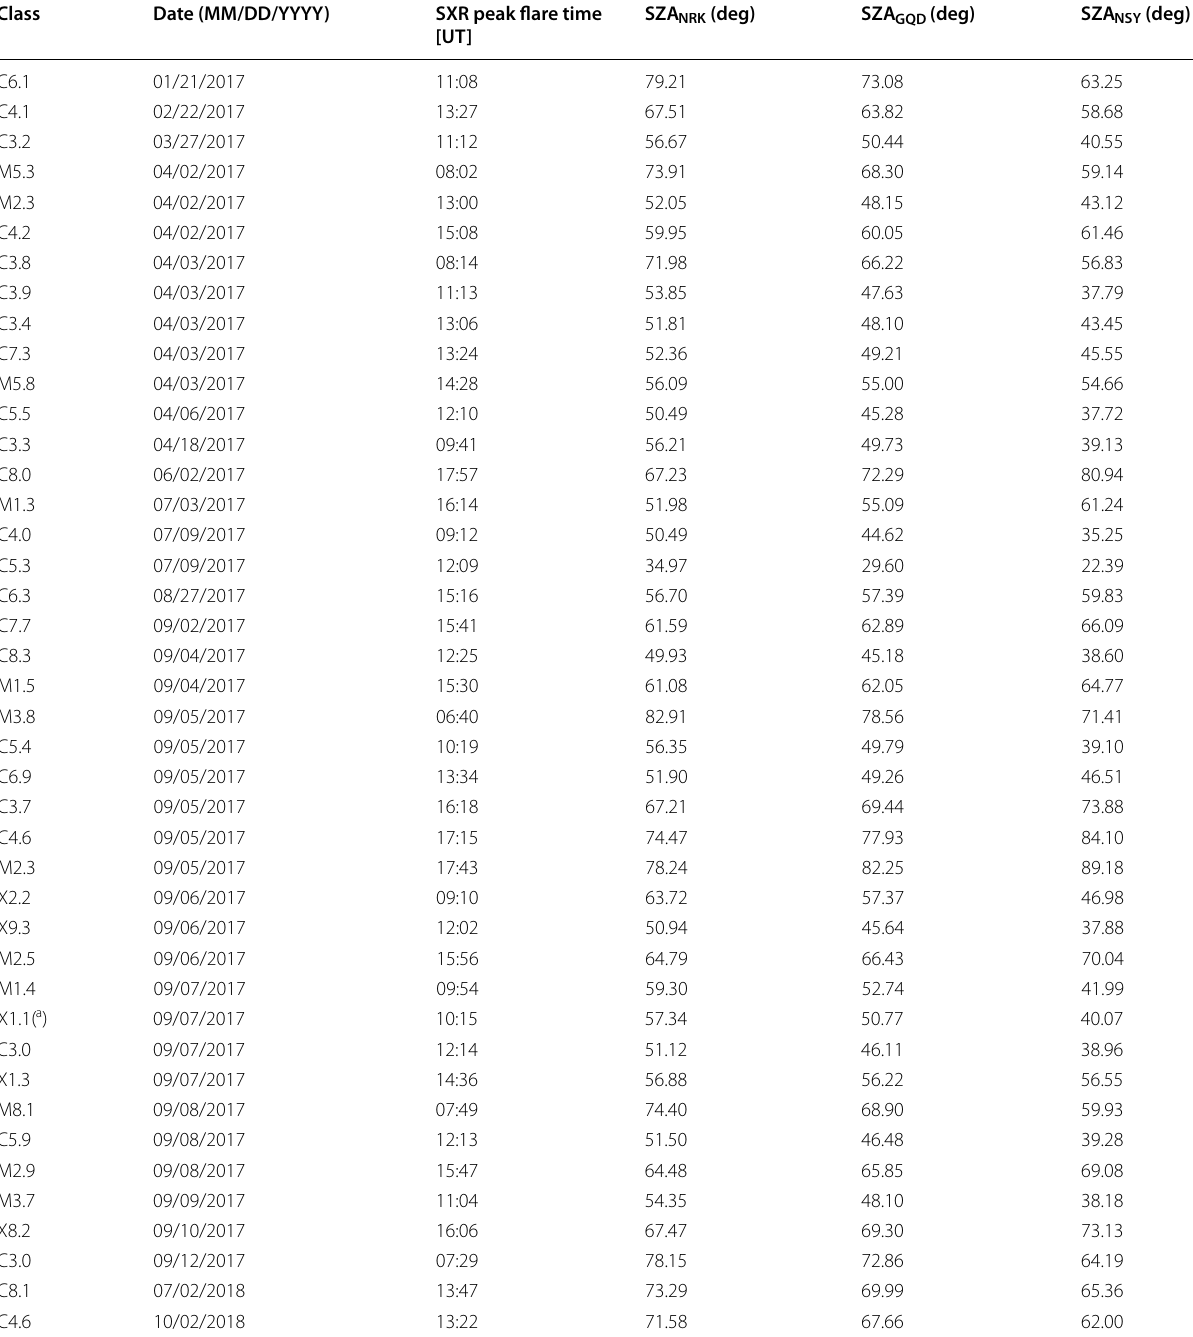
Table 2 Characteristics of the selected